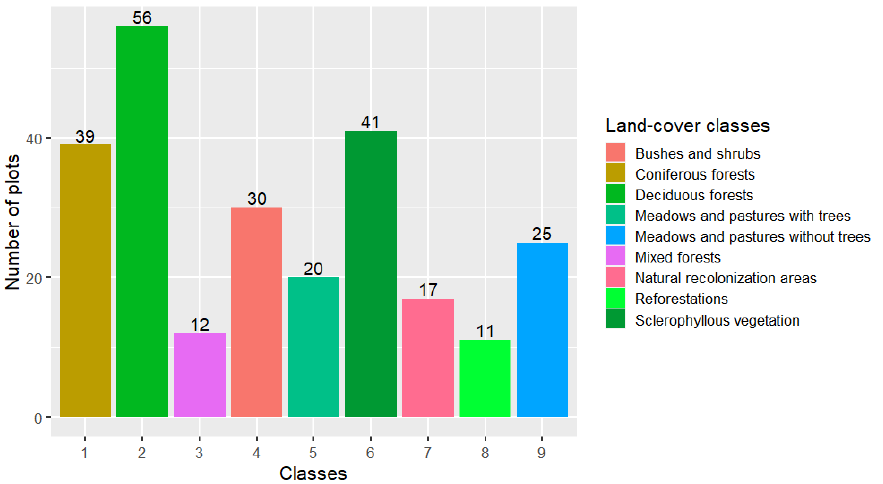
Figure 3. Distribution of land-cover classes within field